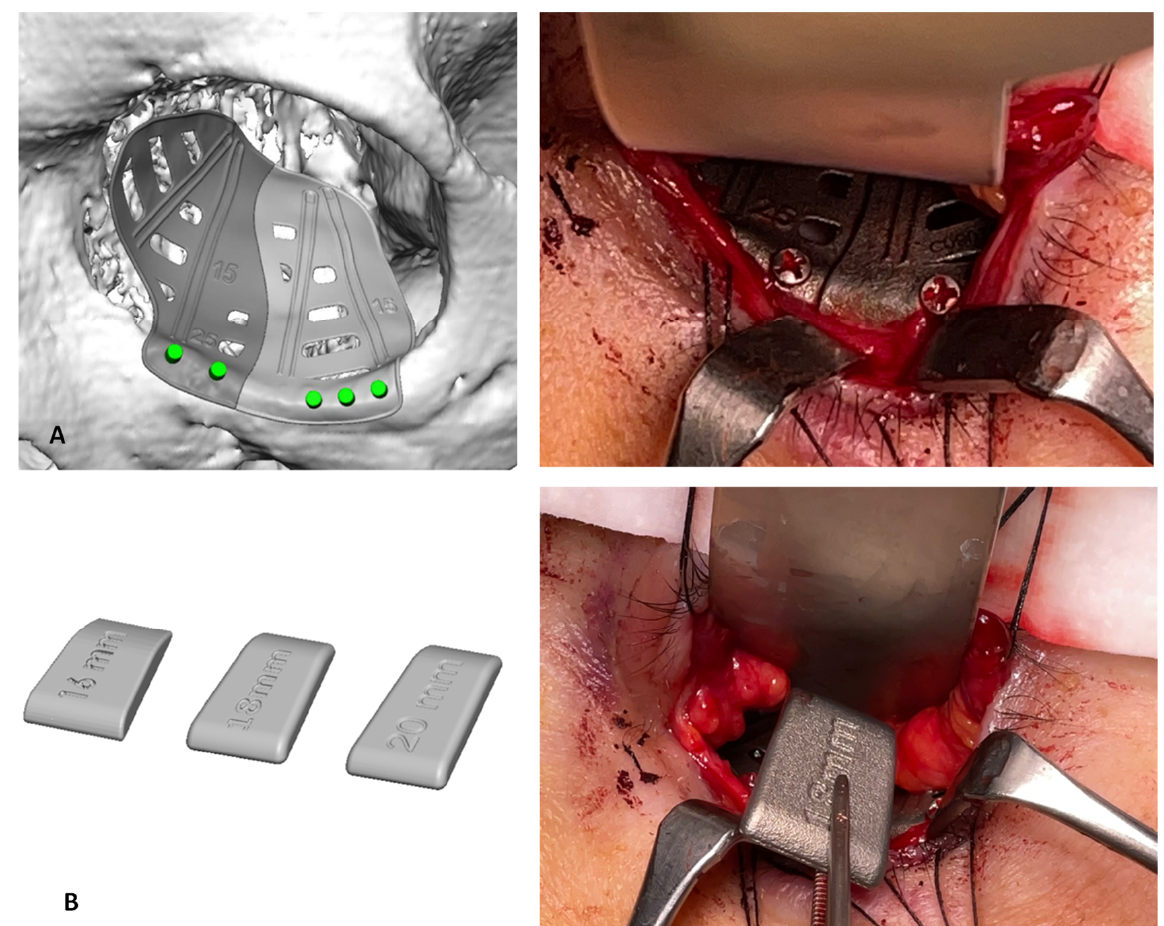
Figure 3. ( A ): The two complementary pieces implant: virtual design and intraoperative imaging. Green dots indicate the holes for screw placement; ( B ): titanium spacers of different lengths (16, 18, 20 mm) and standard thickness (1.5 mm): virtual design and intraoperative imaging.